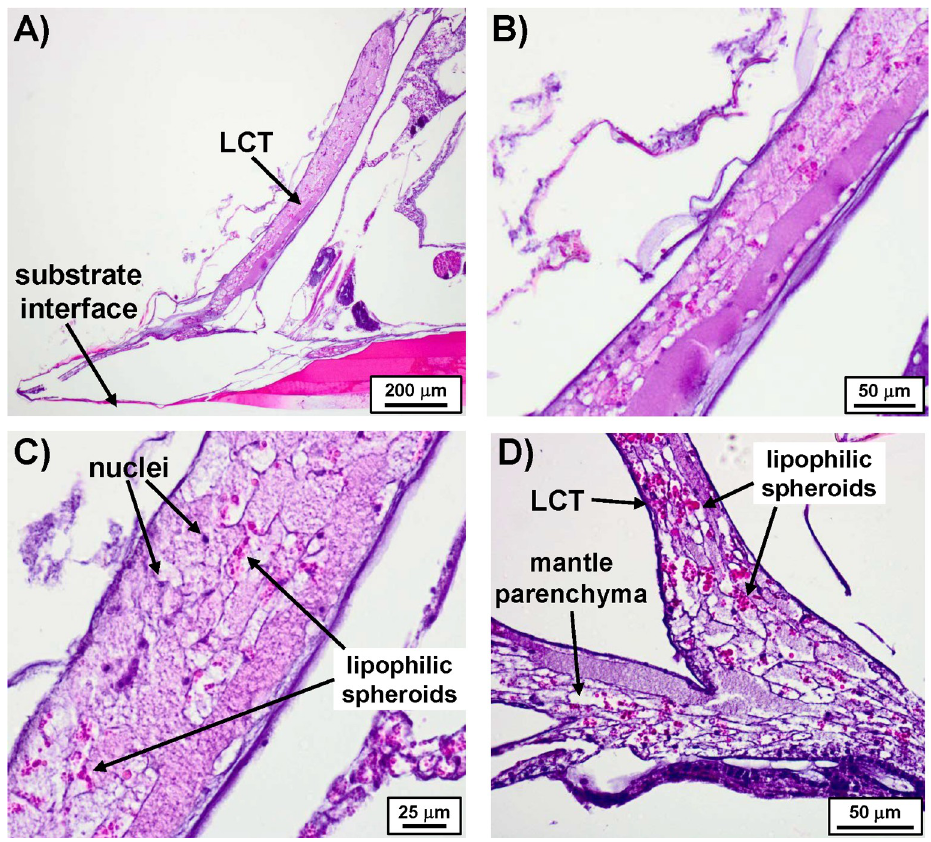
Fig 5. Sagittal sections of LCT stained with H&E. A) Entire view of LCT in relation to the edge of A . amphitrite . B) Magnified image of A) showing the various textures and staining profile. C) Another zoomed image of A)